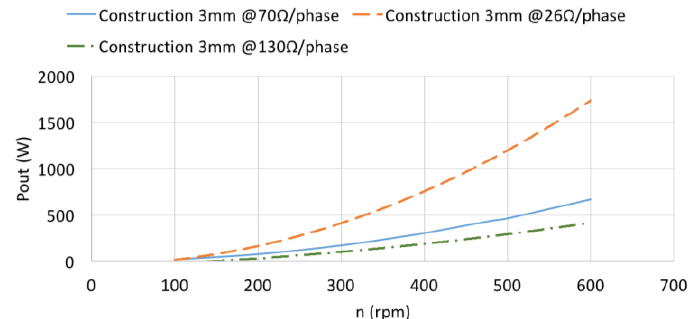
a speed of 375 rpm.